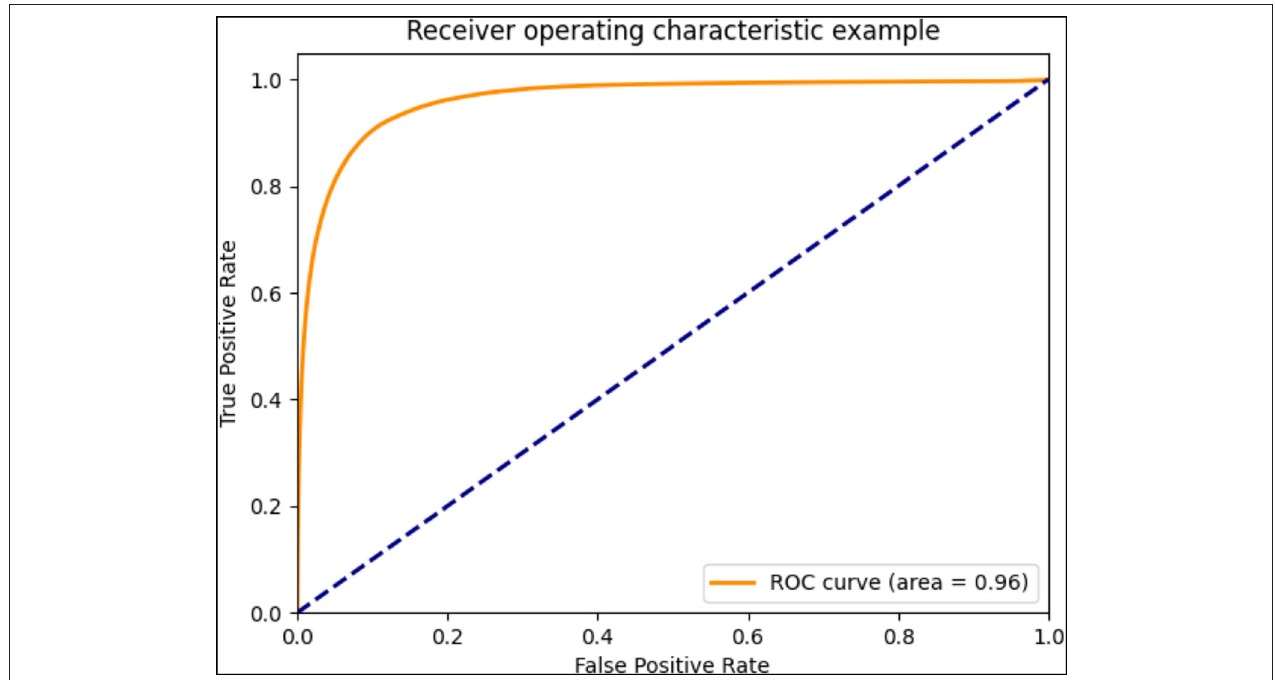
FIGURE 5 | The receiver operating characteristic (ROC) curve of averaged 5-fold cross-validation.